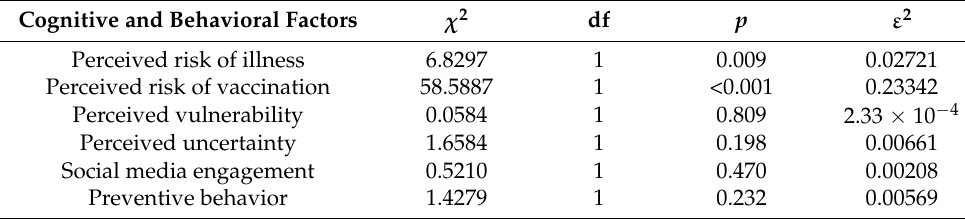
Table 3. Associations between cognitive and behavioral factors and decision to vaccinate.